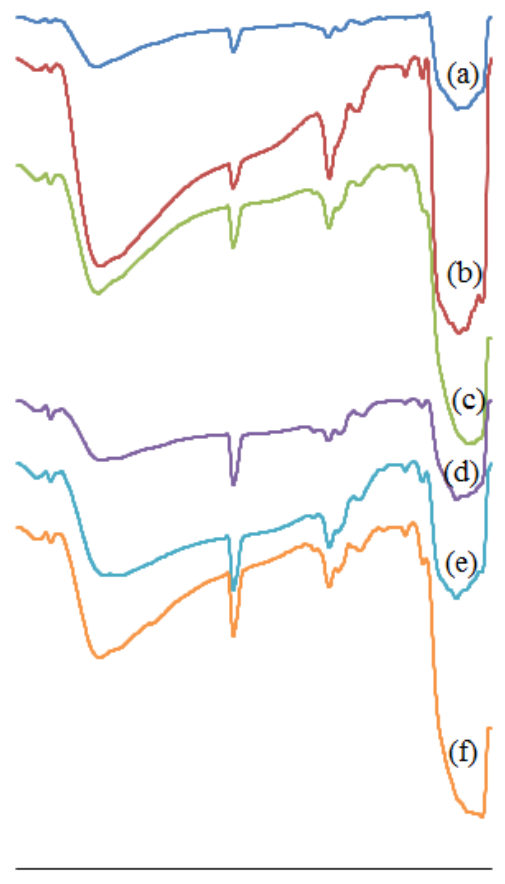
Fig. 3. FTIR spectra of a) TiO